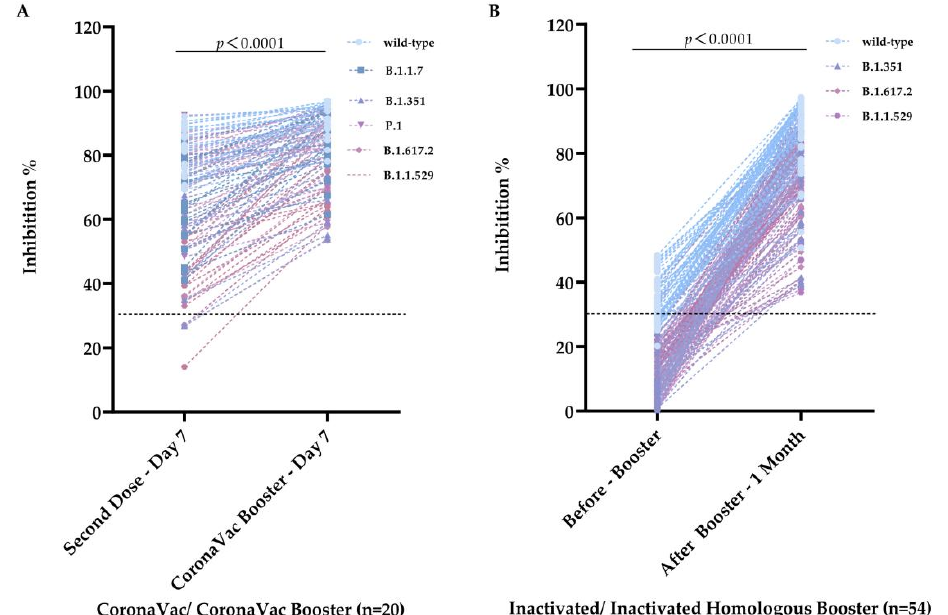
Figure 4. Comparison of the inhibition rates between antibodies induced pre- and post-booster. ( A ) Variation of inhibition rates on 7th day from after the second dose of the CoronaVac booster. ( B ) Variation of inhibition rates from pre- to post-receiving homologous booster. The dotted lines represent the cutoff at 30% inhibition.